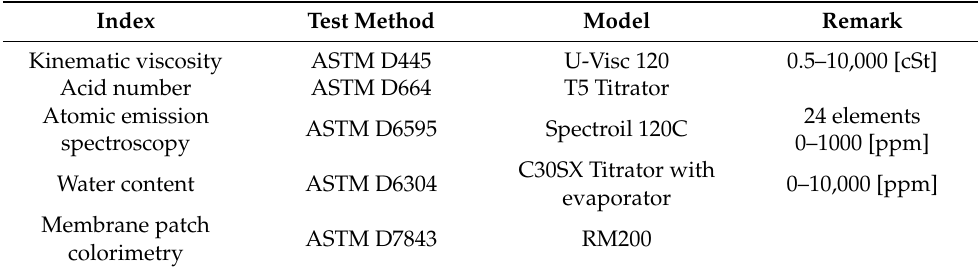
Table 4. Test method and instrument for oil